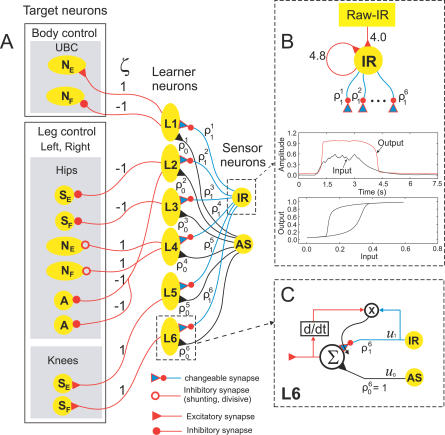
Adaptive Neuronal Controller with Learning Mechanism(A) The adaptive neuronal network. The excitatory synapses r0 projecting from the AS neuron to the learner neurons (black triangles) are all set to 1. While the changeable synapses r1 projecting from the IR neuron to the learner neurons are initially set to 0, they will grow during learning. Eventually, each of them will have converged to different values when learning stops.(B) Recurrent neural preprocessing of the IR signal configured as a hysteresis element. The curves below show the IR signal before preprocessing (Input) and the output signal after preprocessing (Output). The bottom curve presents the hysteresis effect between input and output signals. In this situation, the input varies between 0 and 0.6. Consequently, the output will gradually show high activation (≈1.0; meaning that RunBot approaches the ramp) when the input increases to values above 0.25. On the other hand, it will gradually show low activation (≈0.0; meaning that no ramp is detected) when the input decreases below 0.15.(C) Learning mechanism (see text for details). Note that all learner neurons have the same learning mechanism.